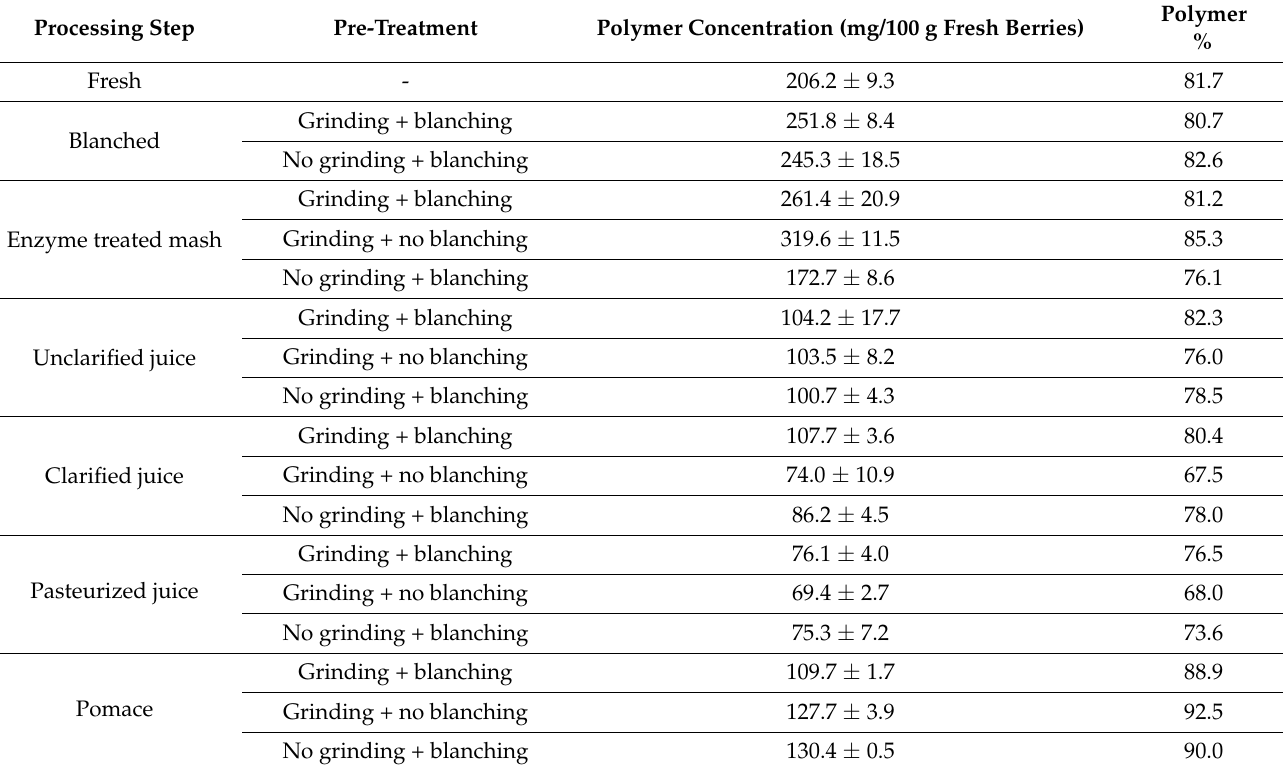
Table 3. Content of polyphenolic compounds depending on cranberry processing step and type of pre-treatment (adapted from White et al. 2011